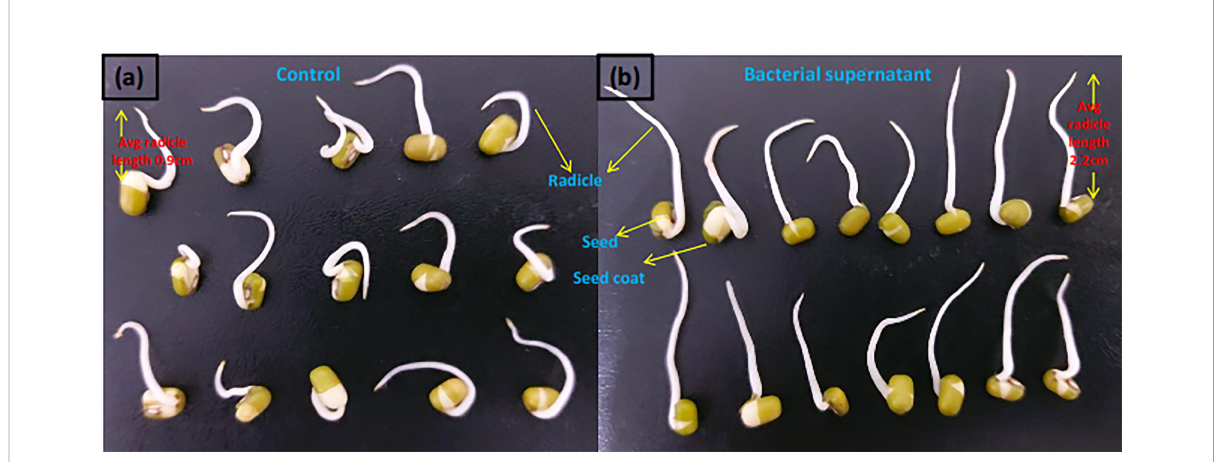
FIGURE 3 Mung ( Vigna radiata ) seed germination effect in (A) control and (B) bacterial supernatant